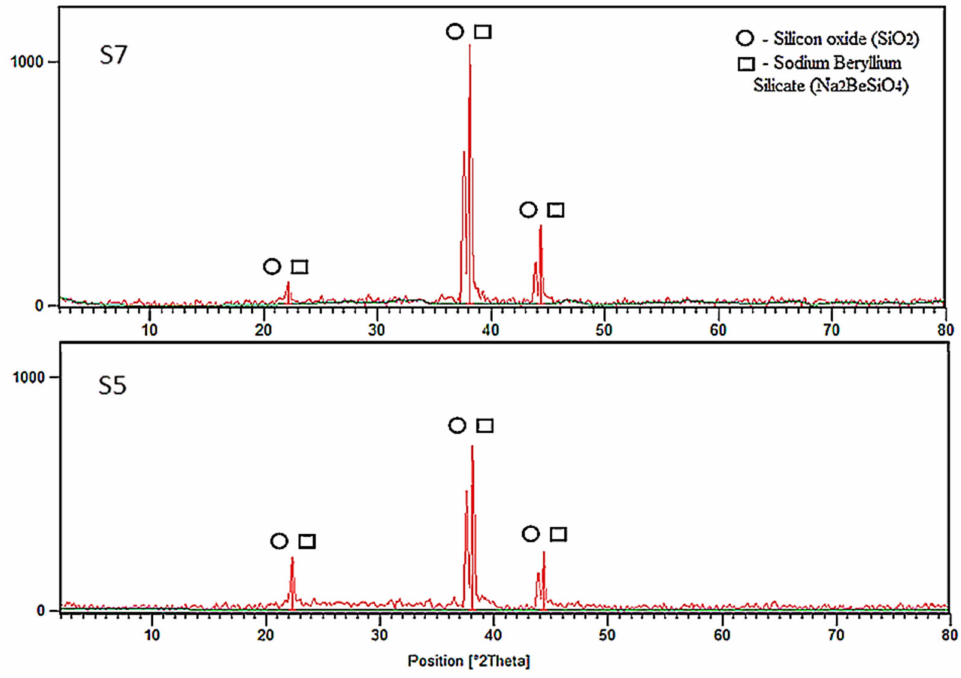
Figure 14. XRD patterns of samples S7 and S5 after fire-retardant